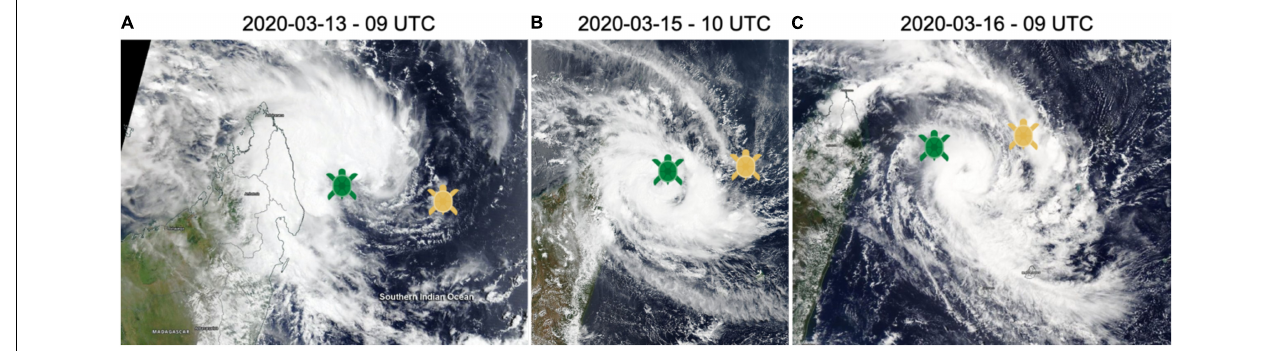
FIGURE 12 | Location of STs “INDIA” (green symbol) and “TOM” (yellow symbol) during the cyclogenesis and intensification phases of tropical cyclone Herold (NE of Madagascar), superimposed on AQUA-TERRA satellite images at (A) 13, (B) 15, and (C) 16 April 2020 at 9, 10, and 9 UTC, respectively.